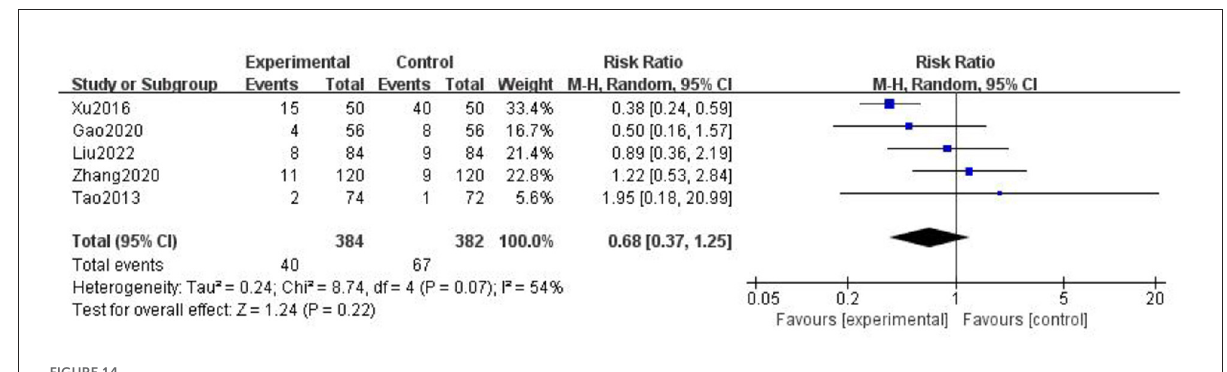
FIGURE14 Forest chart of adverse